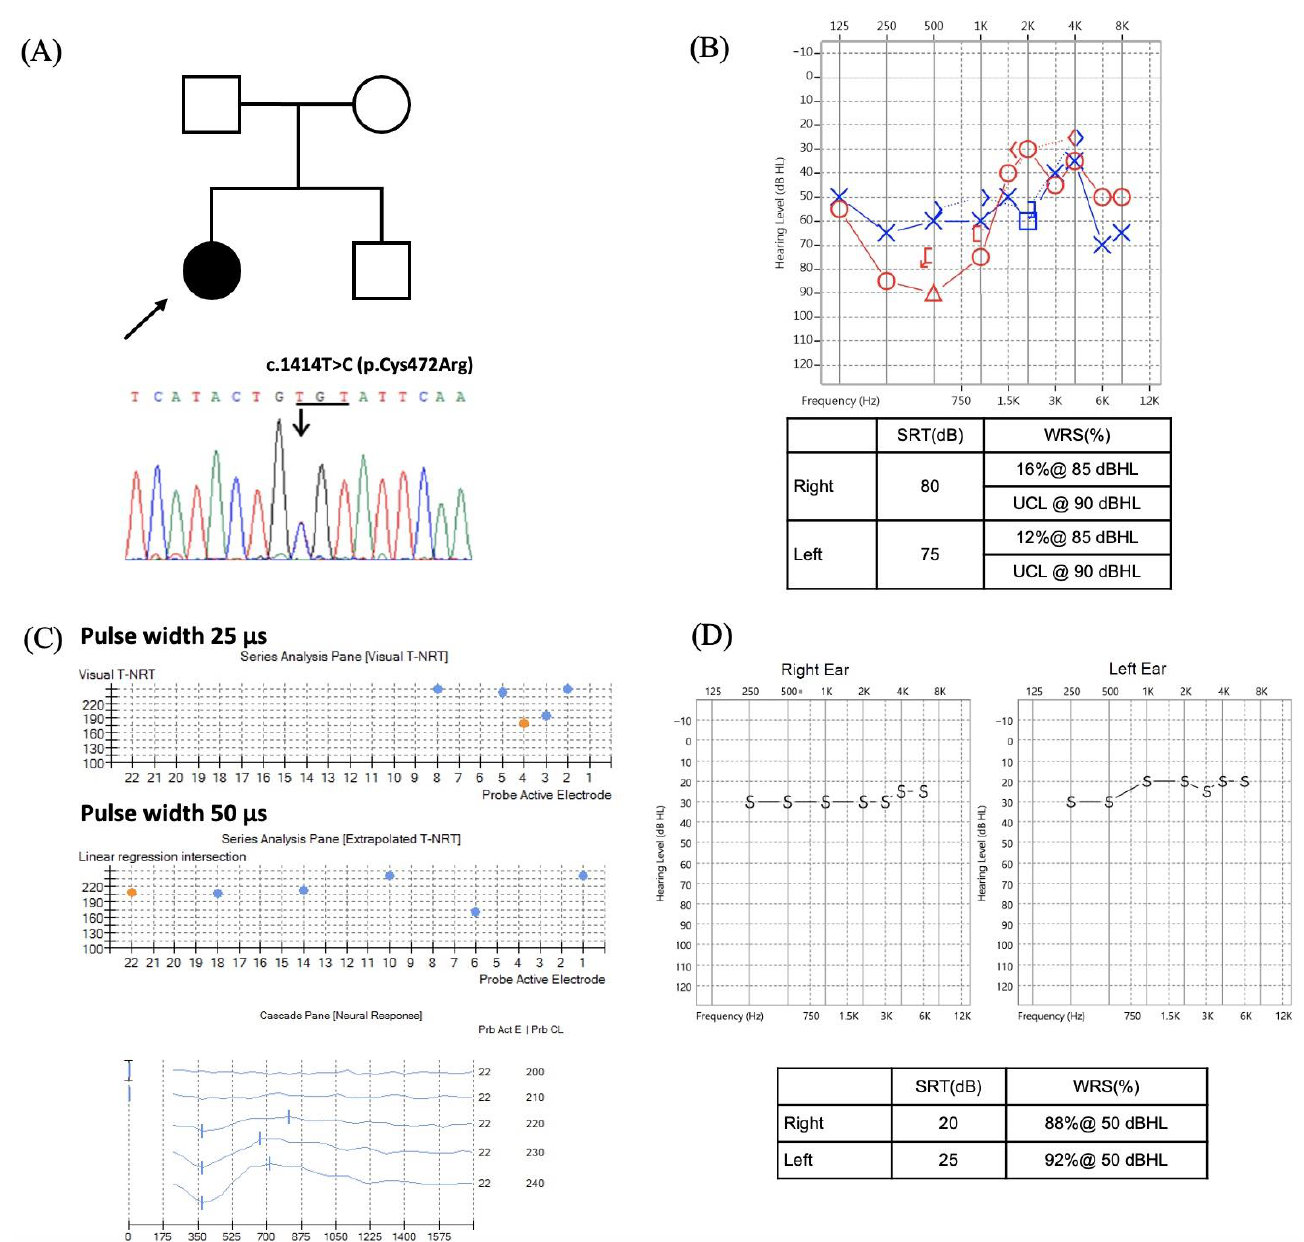
Figure 2. Cochlear implantation outcome in patient with OPA1 c.[1414T>C];[1414=]. ( A ) The heterozygous OPA1 c.1414T>C (p.C472R) variant identified in proband. ( B ) Preoperative pure tone audiogram shows bilateral moderate-to-severe hearing loss (~60–80 dBHL) with poor speech discrimination (word recognition scores: 16% on the right and 12% on the left). Red and blue lines represent the hearing thresholds of right and left ear, respectively. ( C ) The electrically evoked compound action potentials were only recordable at high-frequency electrodes (i.e., electrodes #2, 3, 4, 5, and 8) with regular setting but became more robust with an increase in stimulating pulse width from 25 µs to 50 µs. ( D ) Postoperative behavioral and speech audiometry show ideal cochlear implant-aided thresholds bilaterally and good speech perception. Abbreviations: SRT, speech recognition threshold; WRS, word recognition